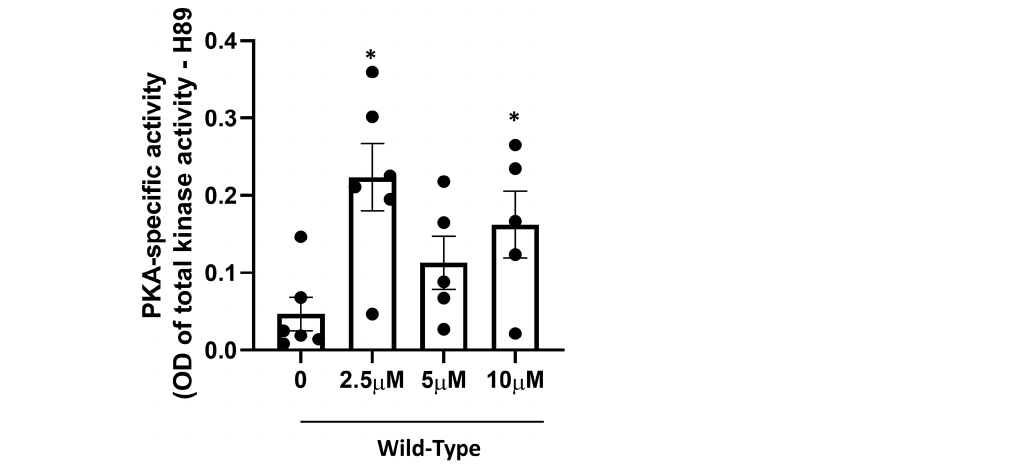
Figure 5. Intranasal delivery of Forskolin increases PKA activity in the cortex of wild-type rats. Bar graph showing the mean total PKA activity assessed in the cortex derived from 10-month-old WT treated with vehicle (Veh) or with increasing concentrations of a single dose of Forskolin (2.5, 5, and 10 µ M) for 24 h and analyzed for PKA activity by using an ELISA-based kit 24 h following treatments. The data were expressed as PKA-specific activity (total activity minus the activity obtained in samples treated with H89) garnered from at least five animals per condition. Mean ± SEM. *: p ≤ 0.05, One ‐ Way ANOVA followed by the Kruskal ‐ Wallis test, 3–6 animals per group). *: p < 0.05 vs. 0 μ M.